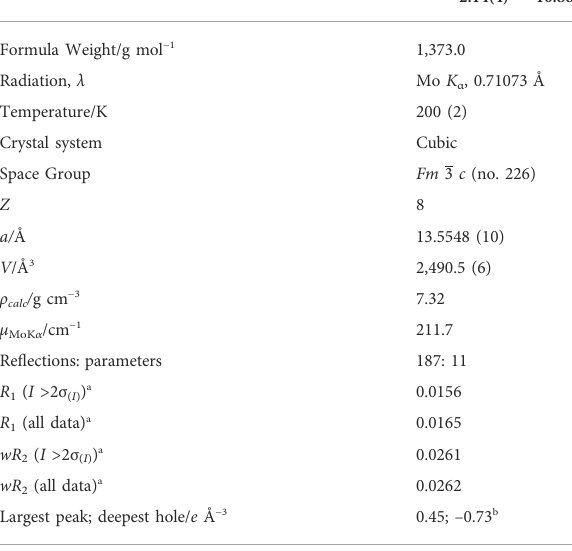
TABLE 1 Selected crystallographic data and structure re fi nement parameters for BaLi x Cd 13 – x ( x ≈ 2).